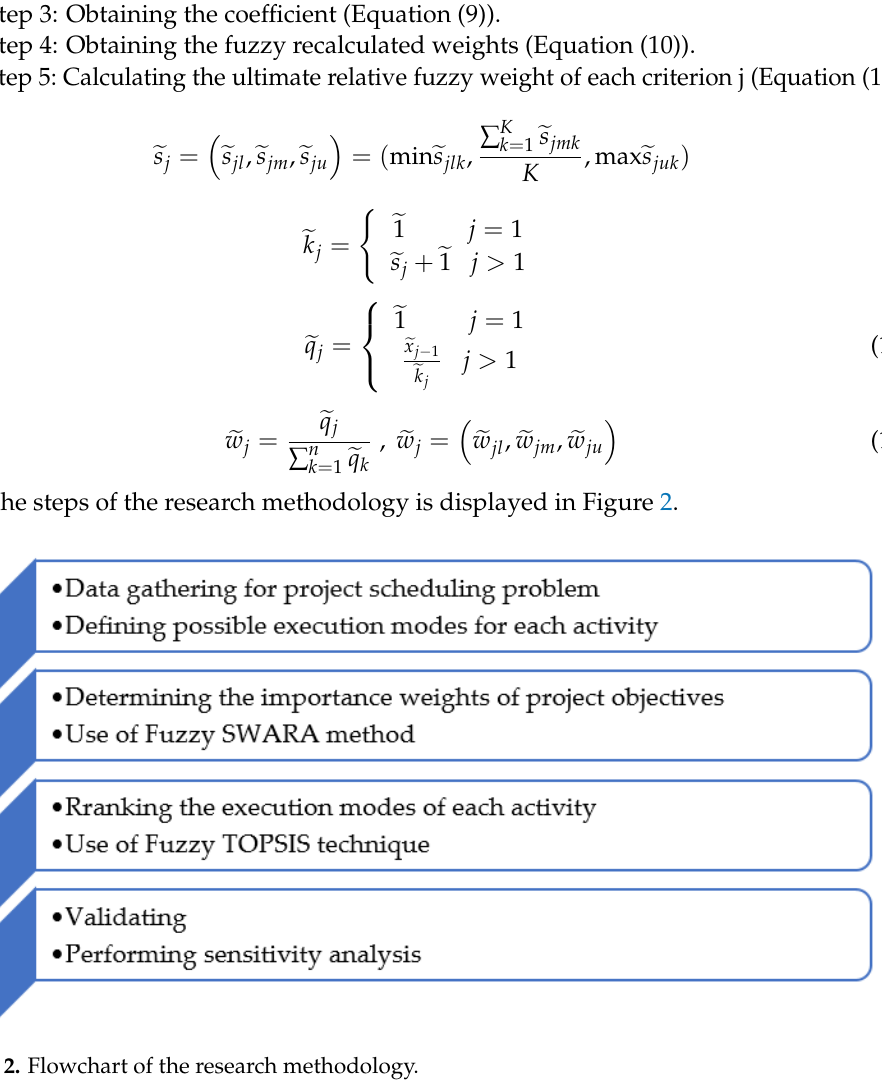
Figure 2. Flowchart of the research methodology.